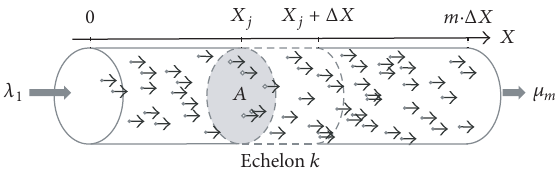
Figure 1: Multi-echelon supply